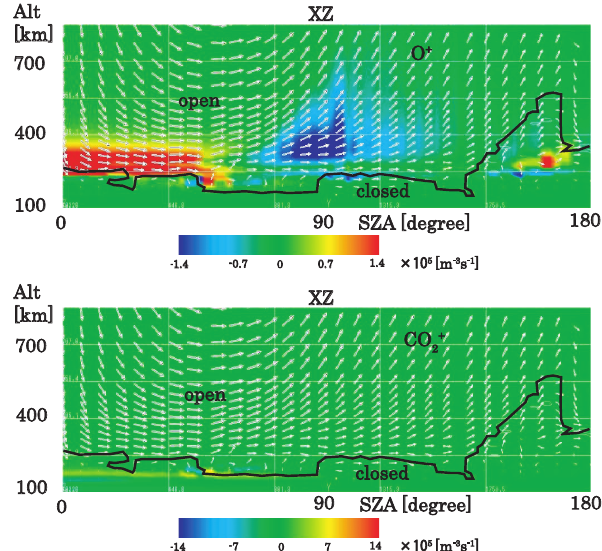
Fig. 11. Contour plots of the net O + (upper panel) and CO + panel) production/loss rates obtained by our MHD simulation in the case of a finite IMF. The format of the figure is the same as that for Fig.